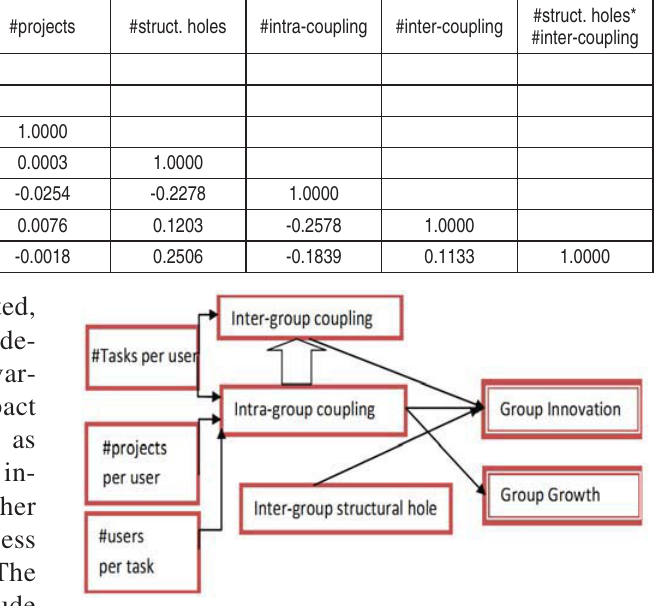
Fig. 7. Illustration of strategy options to augment the group